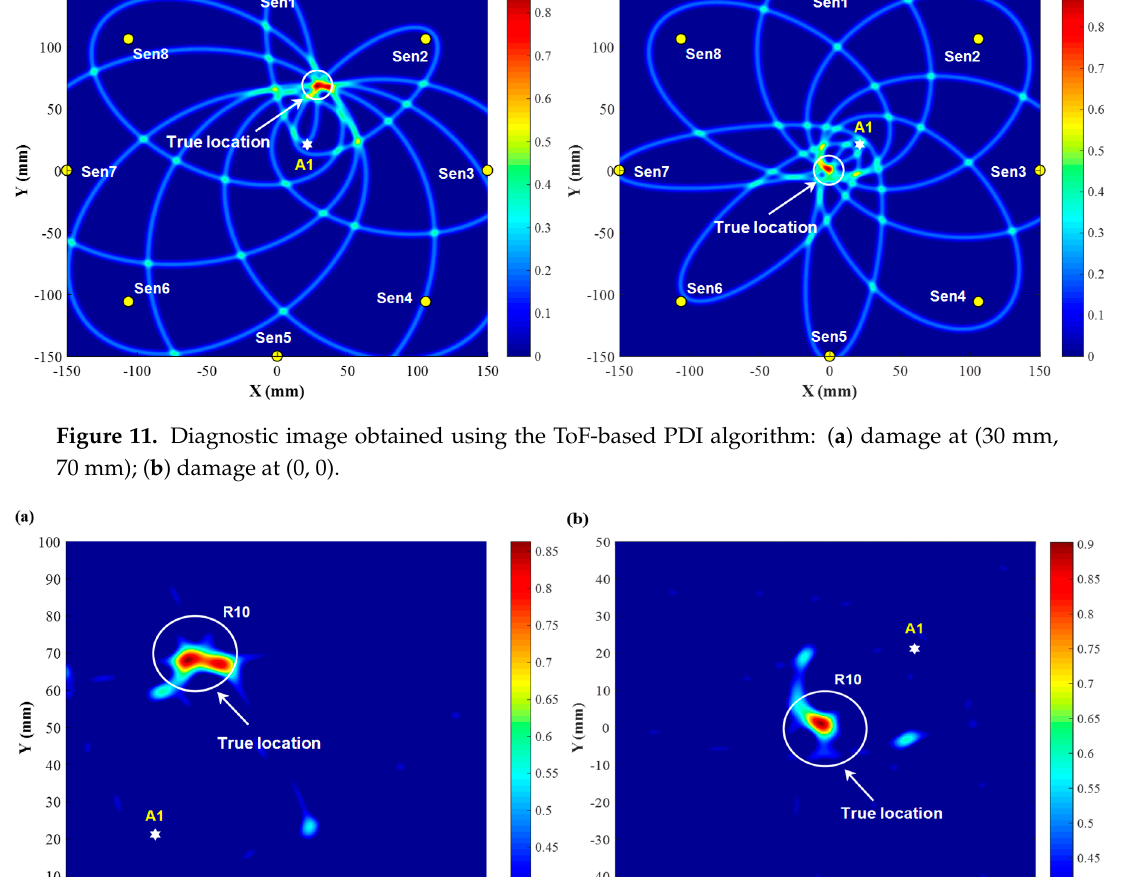
Figure 12. Diagnostic image obtained using the ToF-based PDI algorithm with a threshold value: ( a ) damage at (30 mm, 70 mm); ( b ) damage at (0, 0).